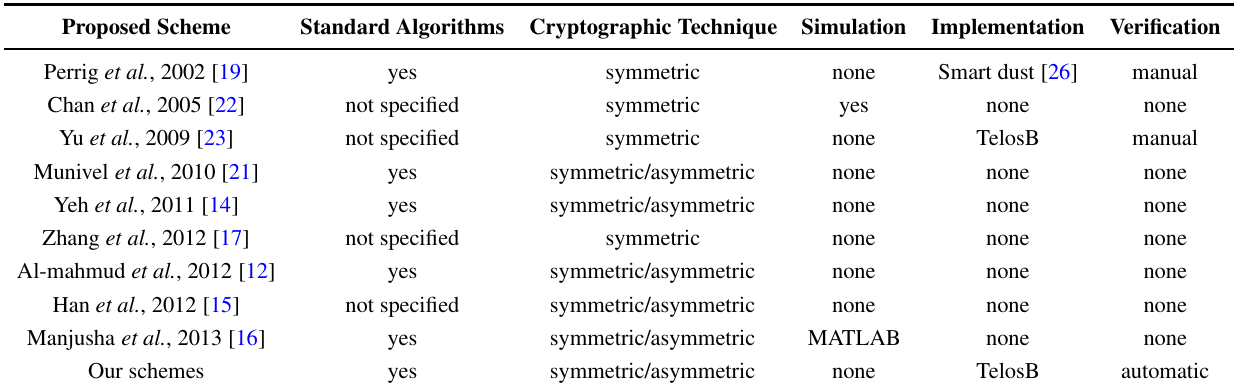
Table 1. Comparison of related work